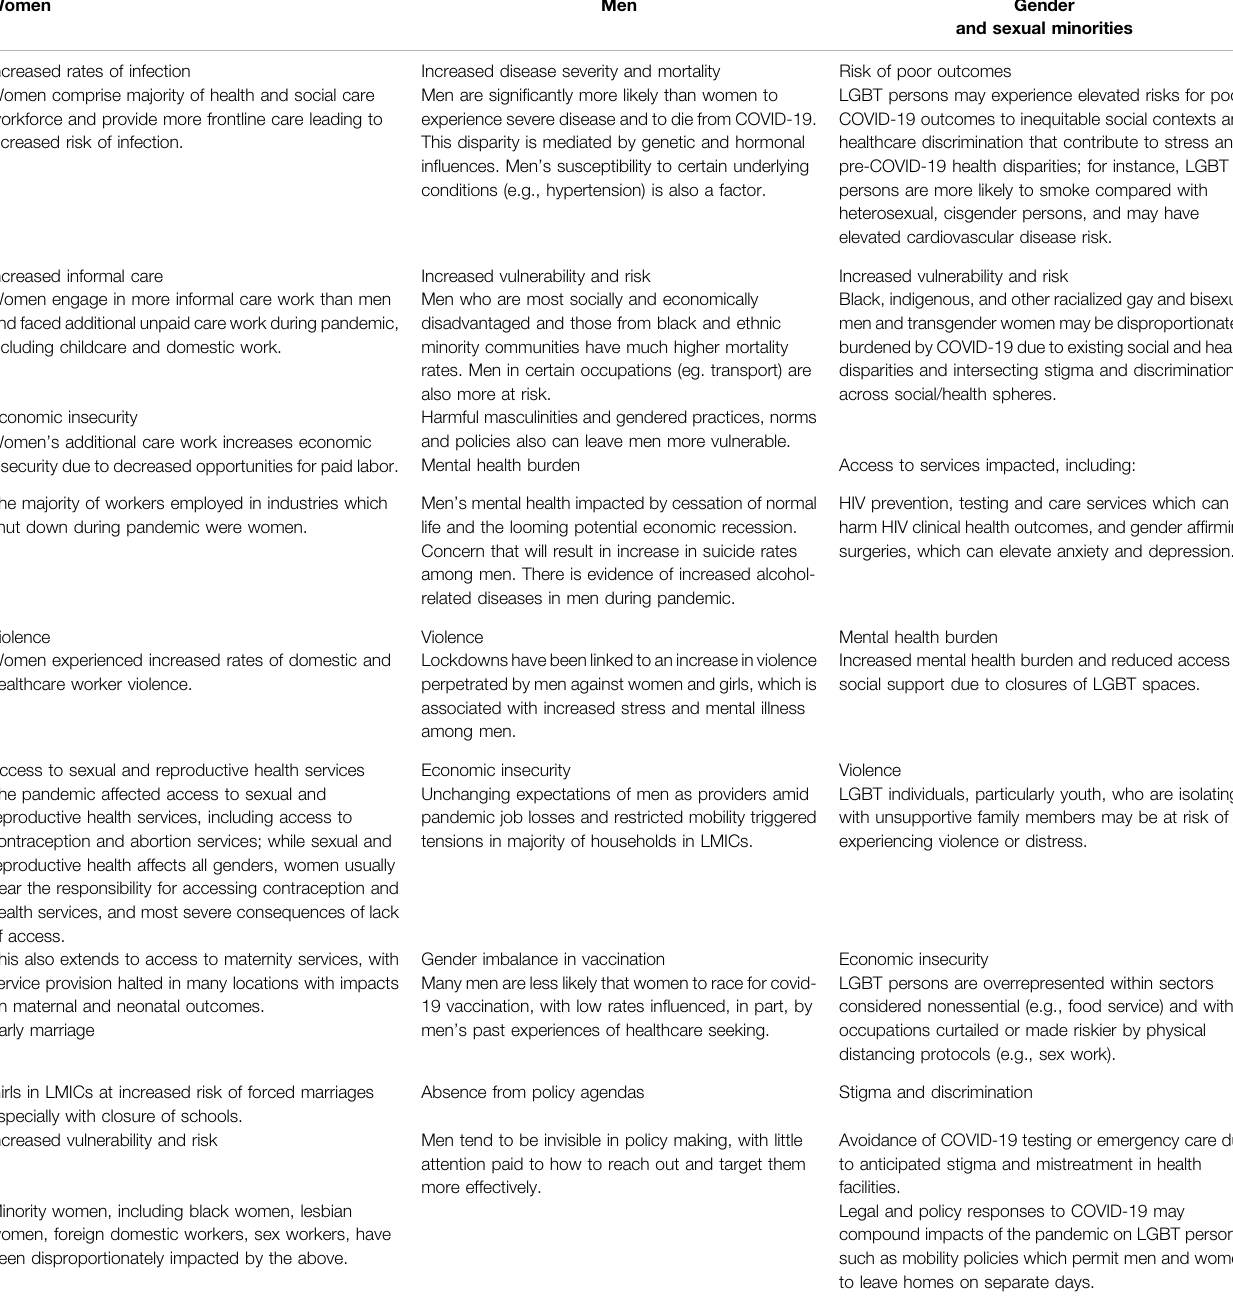
and sexual minorities